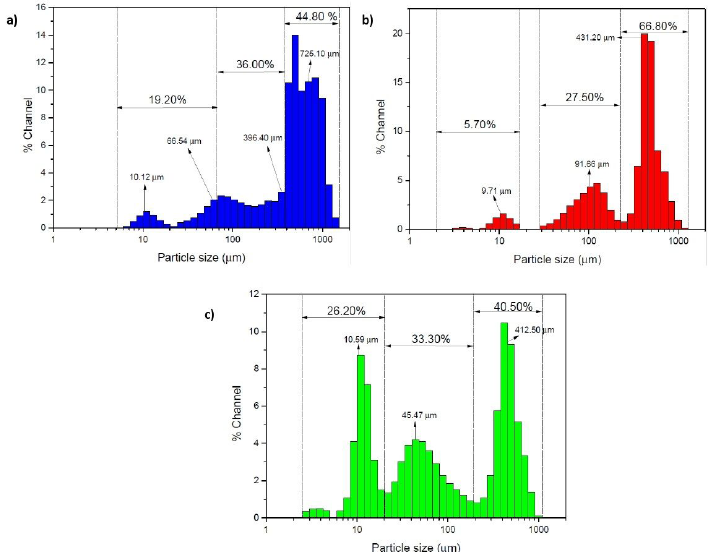
Figure 4: Granulometric distribution of the Vanadis ® 8 milled without carbides addition for (a) 4 hours (b) 8 hours (c) 12 hours